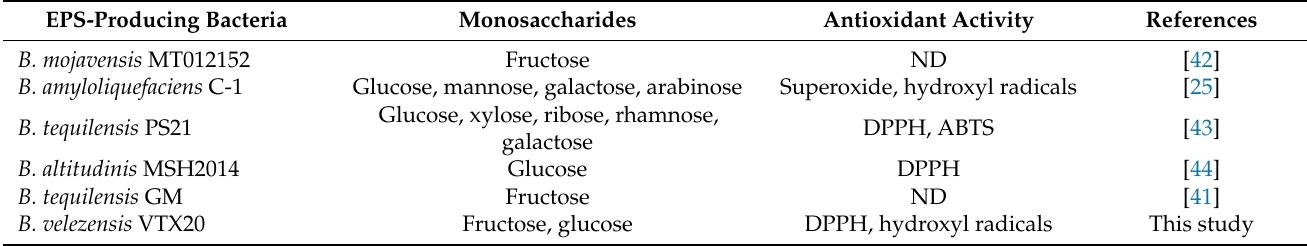
Table 1. Monosaccharide composition of EPS produced by Bacillus strains and their antioxidant activities. EPS-Producing Bacteria Monosaccharides Antioxidant Activity